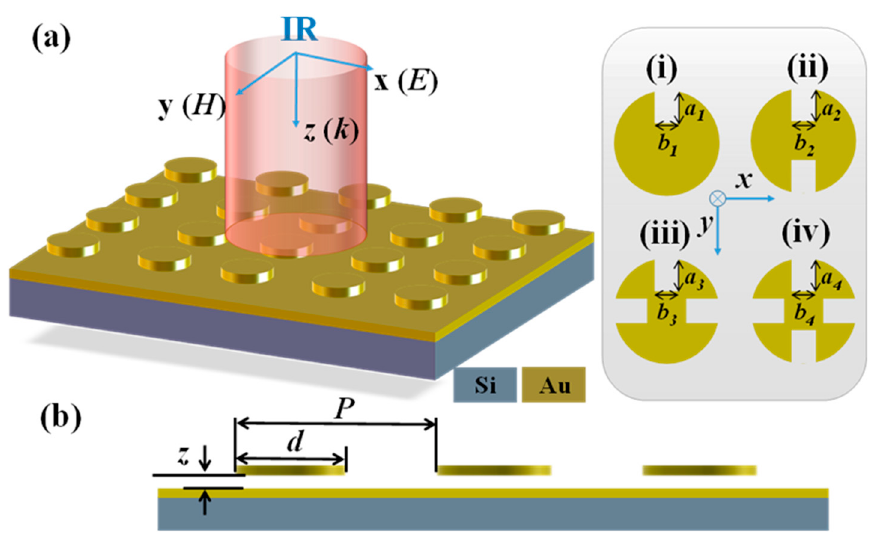
Figure 1. ( a ) Schematic drawing of four types of split-disk metamaterials (SDMs). They are (i) SDM-1, (ii) SDM-2, (iii) SDM-3 and (iv) SDM-4, respectively. ( b ) The cross-sectional view of SDM.